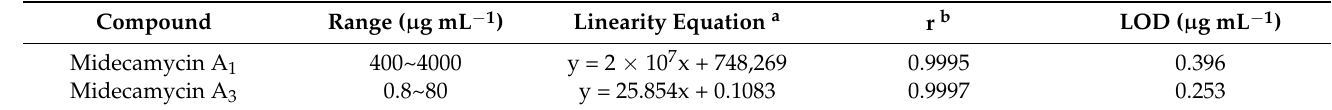
Table 2. Parameters of the calibration equations of midecamycin A 1 and midecamycin A 3 , along with their LOD.